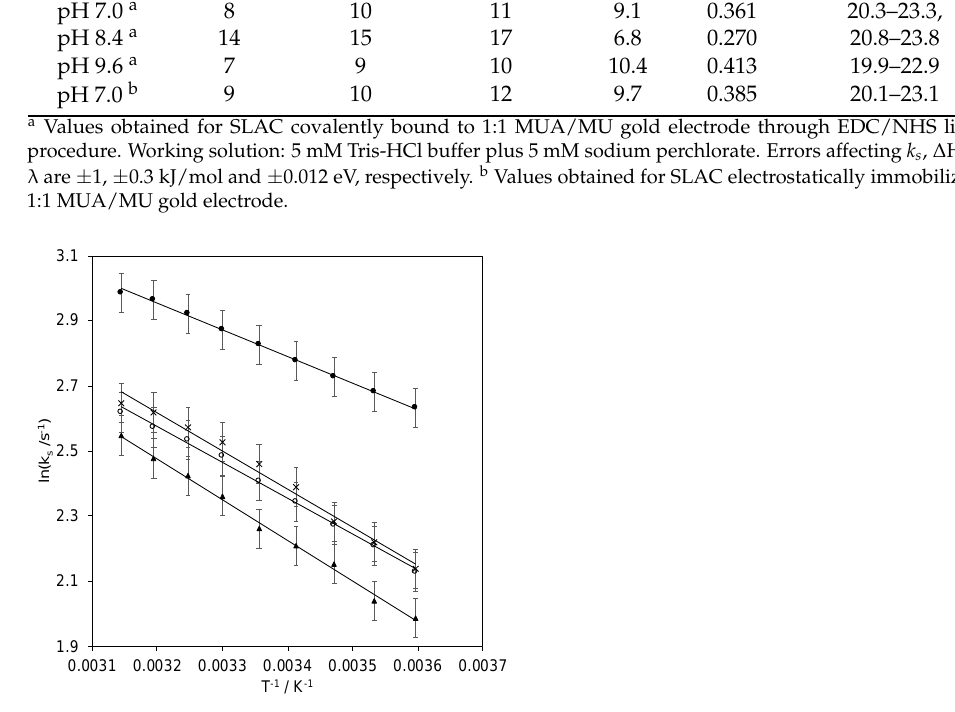
Figure 8. ln k s vs. 1/T plots of Streptomyces coelicolor small laccase (SLAC) covalently bound to 1:1 MUA/MU gold electrode through EDC/NHS linkage procedure at different pH values: pH = 7.0 ( ○ ), pH = 8.4 ( ● ), pH=9.6 ( ▲ ), and electrostatically immobilized on 1:1 MUA/MU gold electrode at pH = 7.0 (× ). Activation enthalpies (ΔH # ) are calculated from the slope of the linear regression curves.